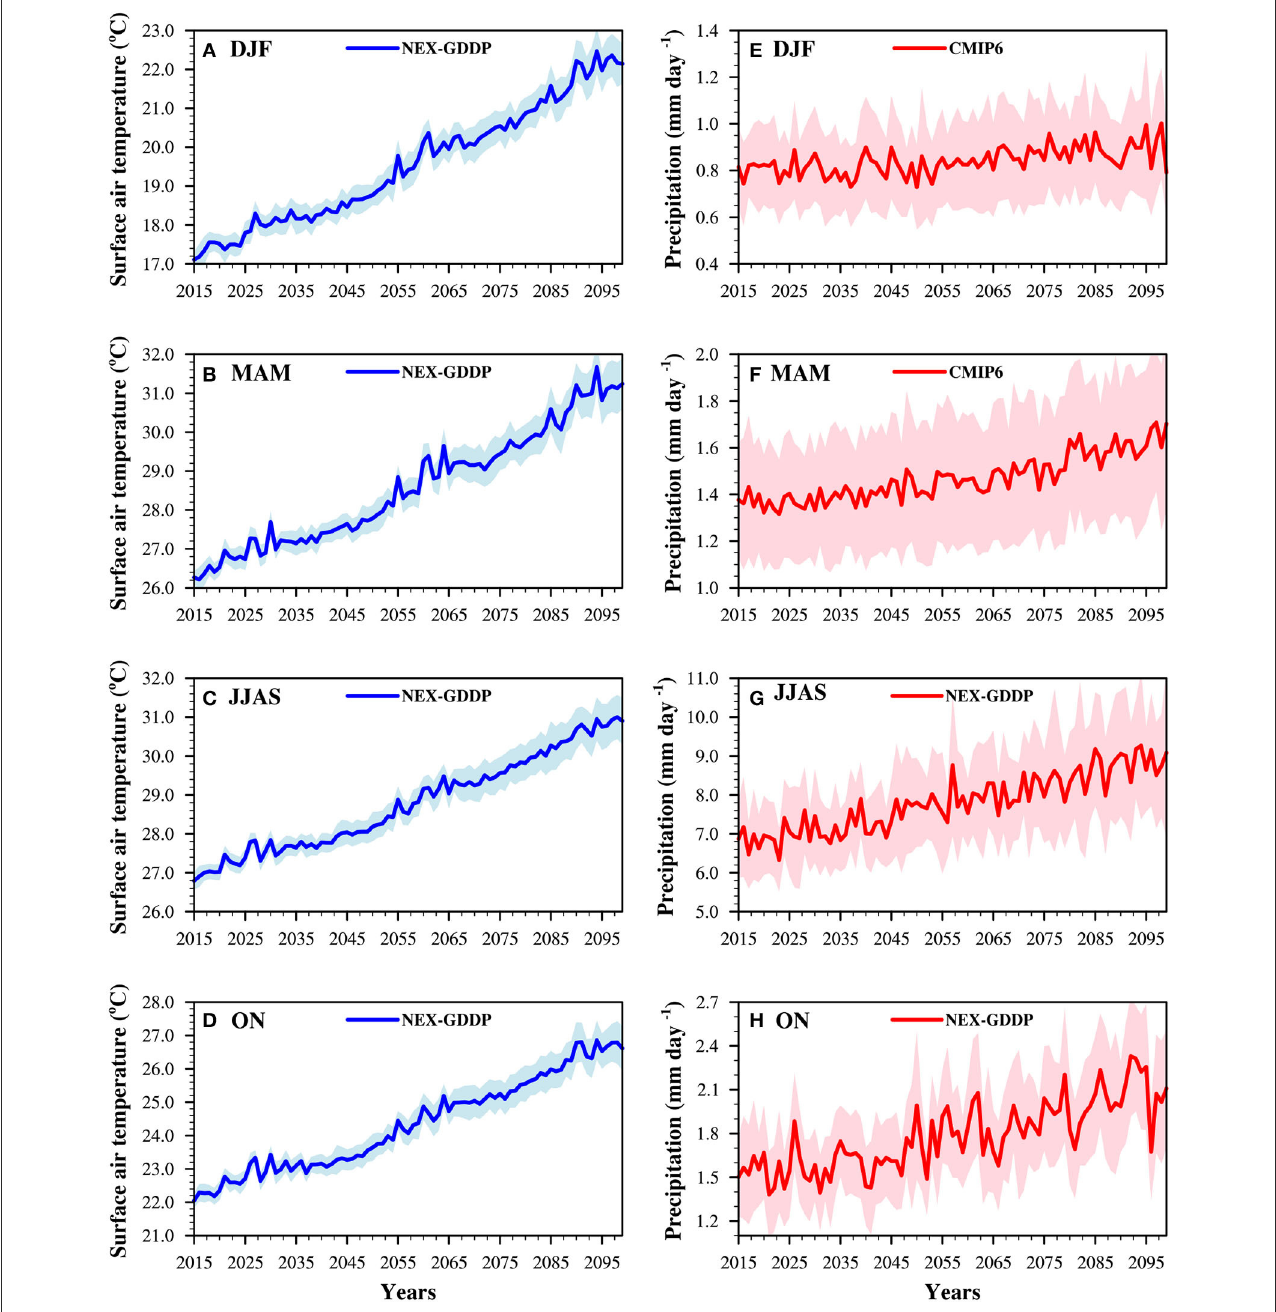
FIGURE3 Time series of surface air temperature (A–D) and precipitation (E–H) for the period 2015- − 2099 for DJF (A, E) , MAM (B, F) , JJAS (C, G) , and ON (D, H) . The text inside the box indicates the MMM used to generate the time series. The solid lines show the MMM and the shadings show the intermodel standard deviation. The emission scenarios used for NEX-GDDP and CMIP6 are RCP8.5 and SSP5-8.5,